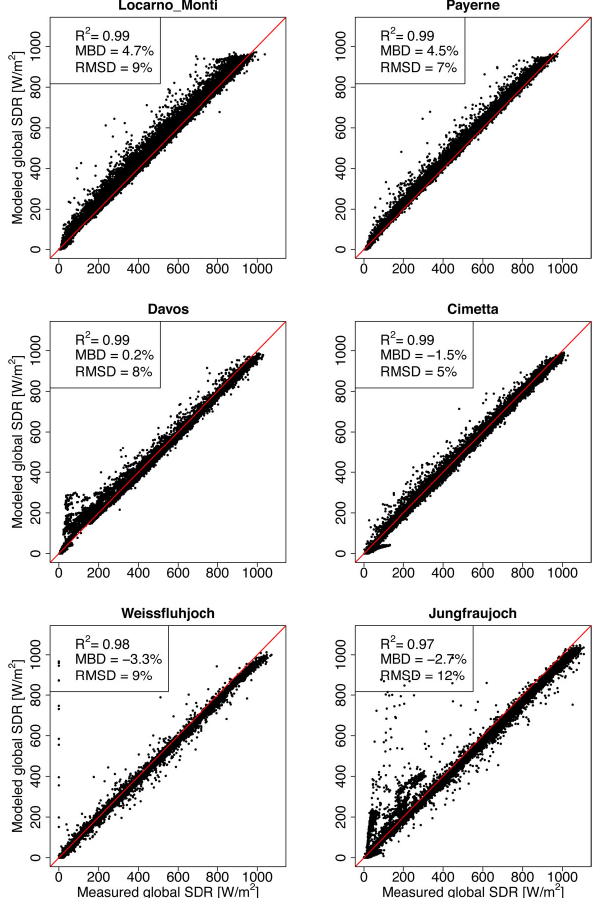
Fig. 3. Scatter plots of global modeled and measured SDR at all locations. The solid red line indicates the perfect